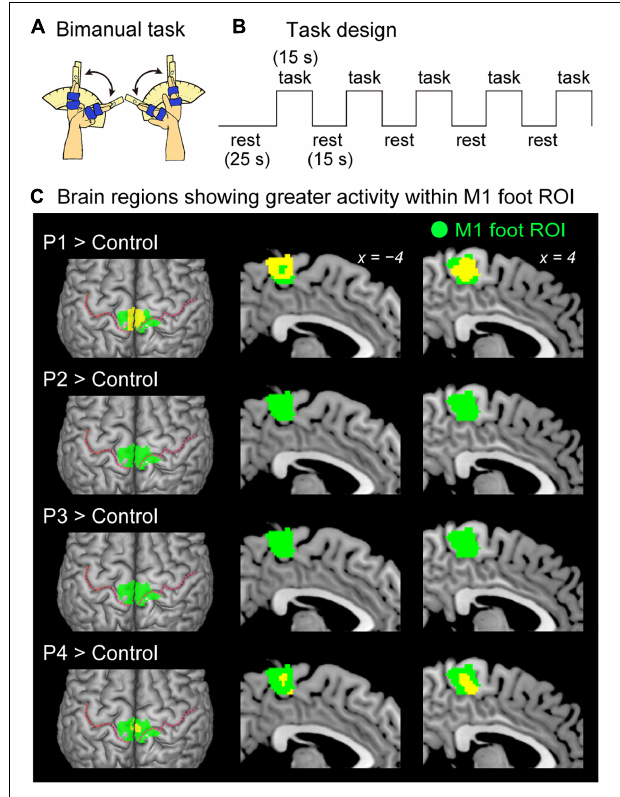
FIGURE 2 | Results from contrast analysis for functional data. (A) Bimanual task used in the present study. All of the participants continuously exert cyclic in-phase extension–flexion movements of their left and right wrists in synchronization with 1-Hz tones. (B) Task design of the bimanual task. Please see the text for details. (C) Results from one-to-many two-sample t -test. Significant clusters of voxels (yellow sections) showing greater activity within the M1 foot ROI when compared with the control participants are shown. Participants P1 and P4 showed a significant cluster (yellow sections) in the M1 foot ROI (green sections). Participant P2 and P3 had no significant cluster. These sections are superimposed on the MNI standard brain. The top view, and sagittal slices (x = –4 and 4) are shown in each row. In each top view panel, pink dotted lines indicate the central sulci. M1, primary motor cortex; ROI, region-of-interest; MNI, Montreal Neurological